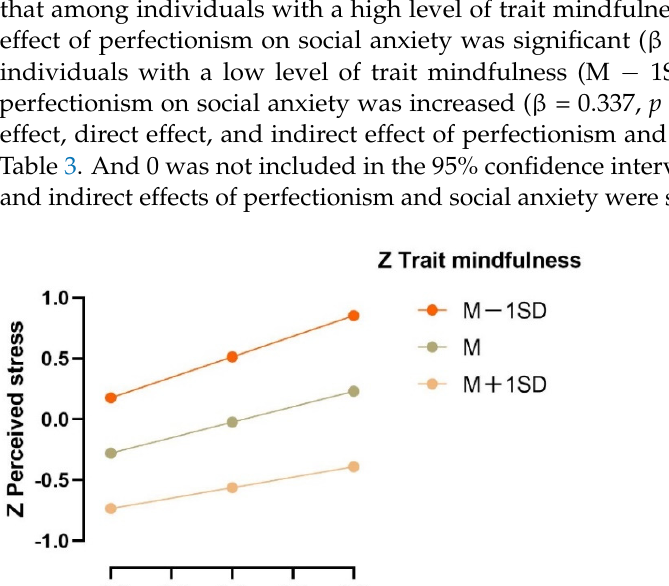
Table 3. Standard total effect, direct effect, and indirect effect of perfectionism and social anxiety (n = 425).